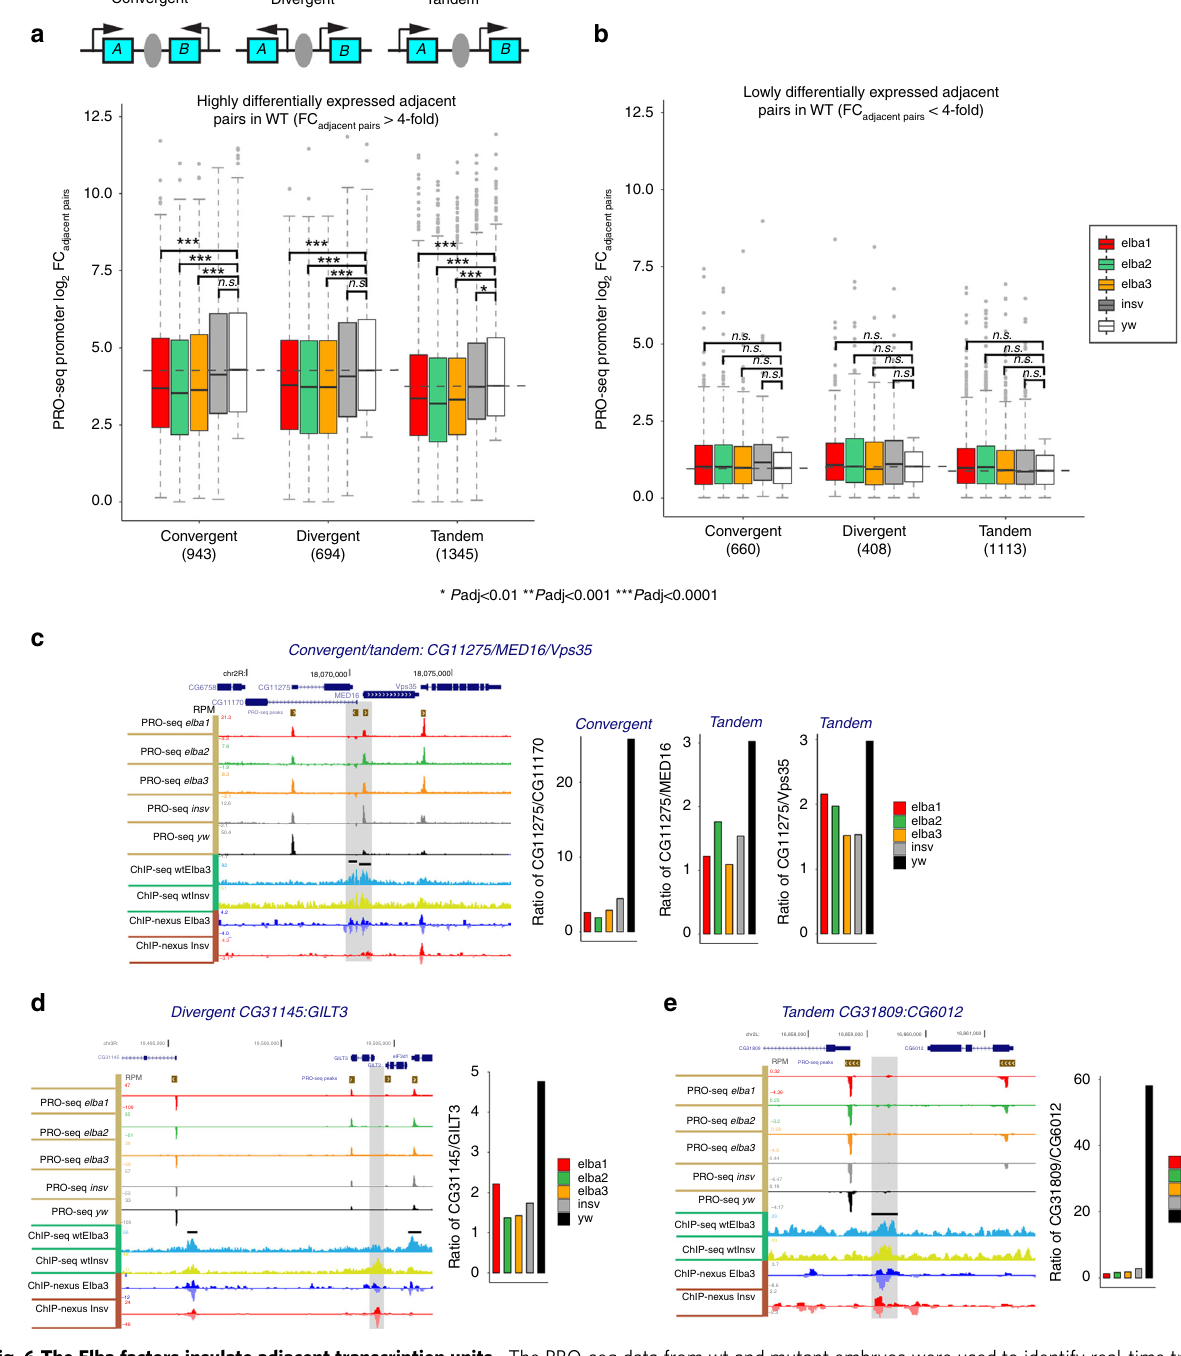
Fig. 6 The Elba factors insulate adjacent transcription units. The PRO-seq data from wt and mutant embryos were used to identify real-time transcripts produced by RNA Pol II in each genotype, and de novo PRO-seq peak calling was made to de fi ne active promoters. a , b We considered three types of adjacent promoter-pair con fi gurations, convergent, divergent, and tandem, fl anking an ELBA/Insv peak. Differential expression between adjacent promoter pairs (absolute FC adjacent pairs ) were divided into ( a ) the highly differentially expressed (>fourfold) and ( b ) the lowly differentially expressed (< fourfold) pairs in the wild type (wt). a Signi fi cant reduction of expression difference between highly differentially expressed neighbor promoters in the three ELBA mutants, but not in insv mutant. b Lowly differentially expressed gene pairs do not show signi fi cant changes in any of the mutants. Statistical signi fi cance was calculated using two-tailed t tests, and the p -values were adjusted by the Bonferroni multiple testing correction method (* p < 0.01, ** p < 0.001, *** p < 0.0001). c – e Three exemplary loci with convergent, divergent, or tandem gene pairs fl anked by the ELBA/Insv-binding peaks. The bar plots on the right show the ratio of expression (RPM) of the two adjacent promoters in each genotype determined by PRO-seq read coverage of the promoter-proximal regions. The boxplots are de fi ned: center line, median; box limits, upper and lower quartiles; whiskers, 1.5x interquartile range; points,